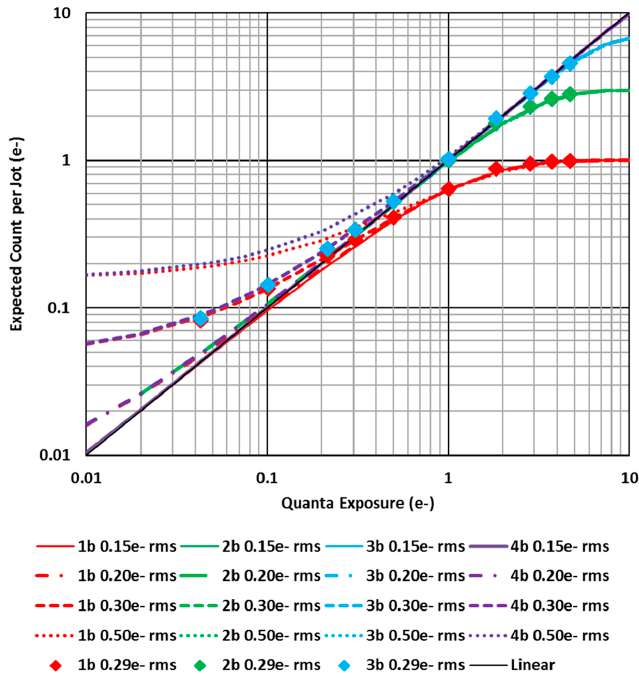
Figure 8. Expected count vs. quanta exposure for various bit depths and read noise levels. Experimental data is shown by the diamond symbols (after [21]).